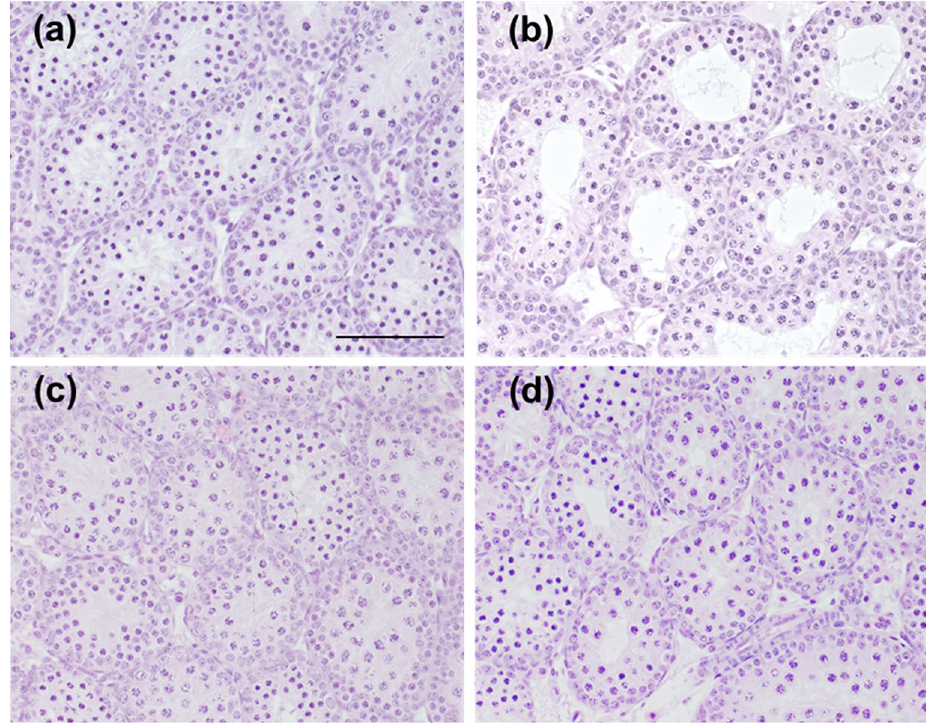
Figure 4. Testicular histology of CORT-administered mice on PND 16. Testicular histology of control ( a ), low-dosed ( b ), middle-dosed ( c ), and high-dosed-CORT mice ( d ) on PND 16. Representative H&E-stained micrographs are provided. The scale bar is 100 µm.